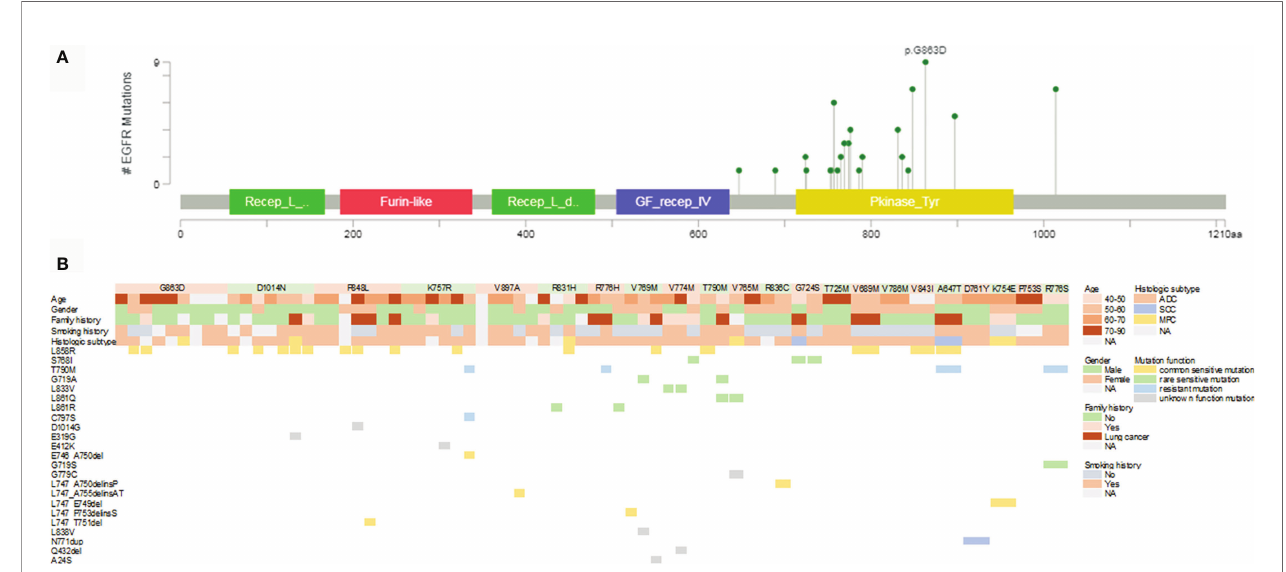
FIGURE 1 | Mutational landscape of germline and somatic EGFR gene mutations. (A) Lollipop plot of the distribution of EGFR germline mutations. (B) Mutational pro fi les of patients with germline EGFR mutations. EGFR, epidermal growth factor receptor; ADC, adenocarcinoma; SCC, squamous cell carcinoma; MPC, multiple primary carcinoma; NA, not